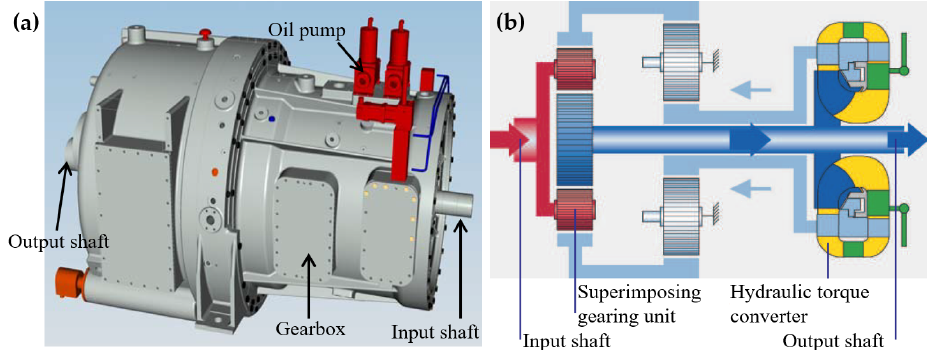
Figure 5. Hydraulic transmission WinDrive [86]: ( a ) a three-dimensional view and ( b ) the power flow in WinDrive that consisted of a superimposing gearing unit and a hydrodynamic torque converter.